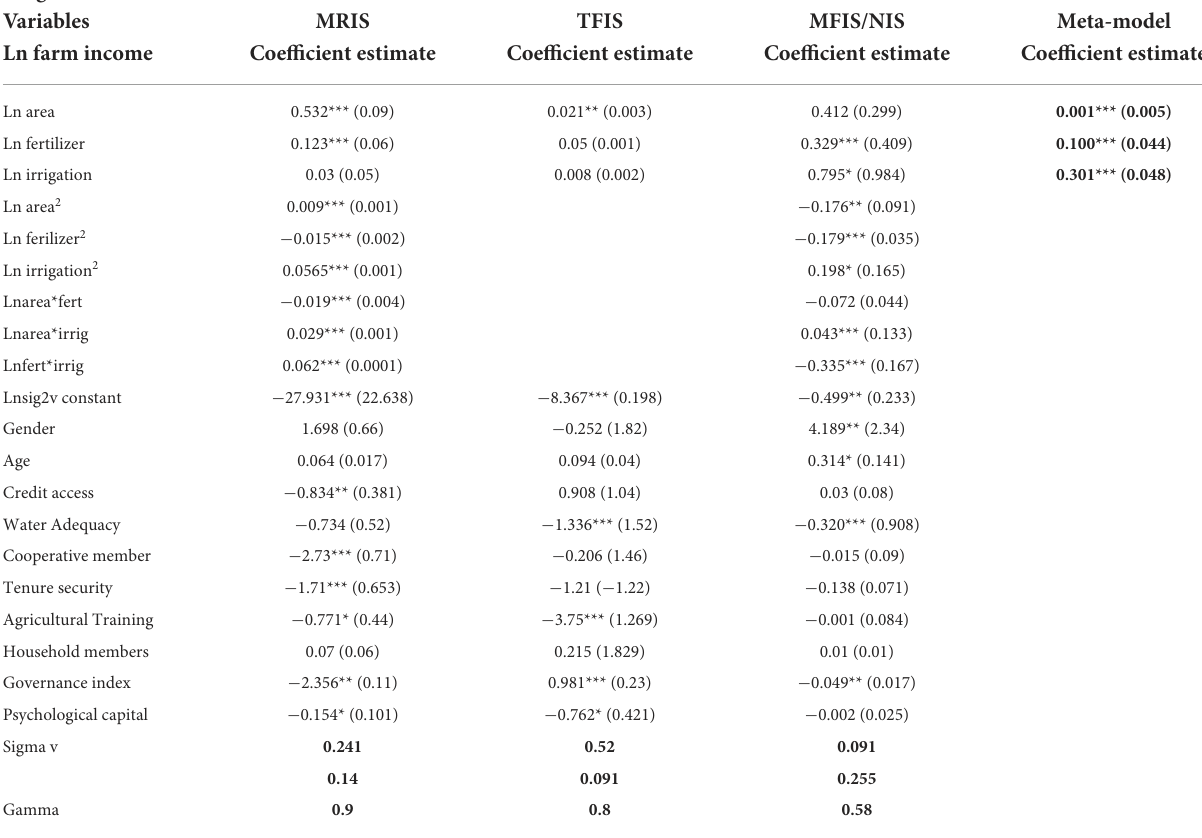
TABLE 4 Stochastic frontier estimates of technical efficiency in SIS. Irrigation